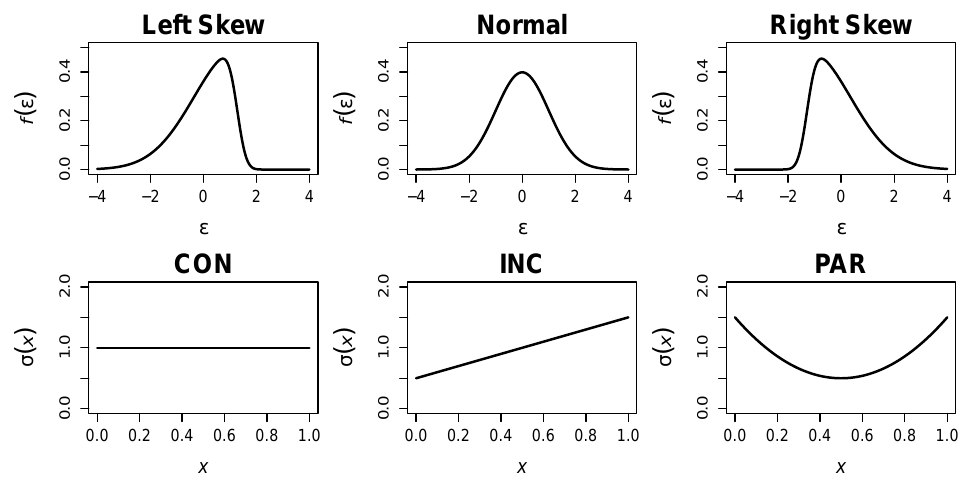
Figure 1. Simulation A Design. The top row shows the three data generating distributions, which each have mean µ = 0 and variance σ 2 = 1. The bottom row shows the three error standard deviations: CON is constant error standard deviation with σ ( x ) = 1, INC is increasing the error standard deviation with σ ( x ) = 1/2 + x , and PAR is a parabolic error standard deviation with σ ( x ) = 1/2 + 4 ( x − 1/2 ) 2 . All nine combinations (= 3 f ( (cid:101) ) distributions × 3 σ ( x ) patterns) of these data generating factors were explored in the